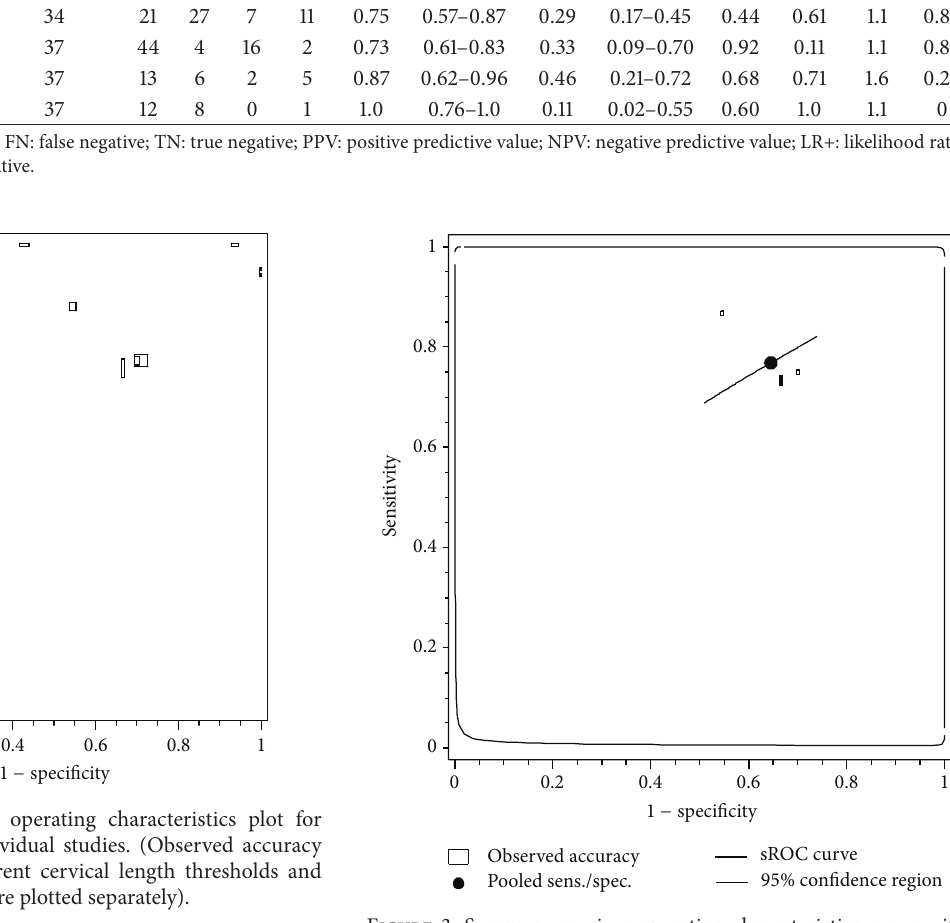
Figure 3: Summary receiver operating characteristics curve